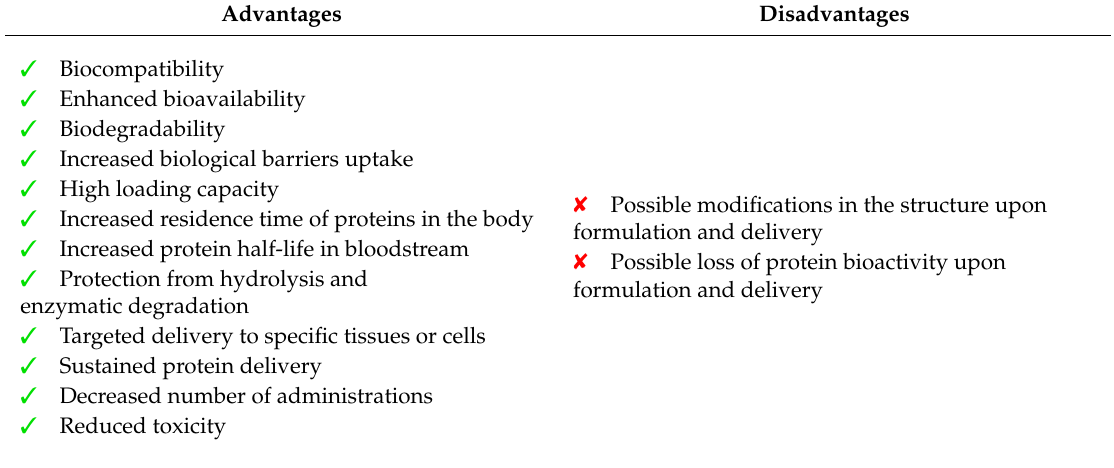
Table 1. Advantages and disadvantages of protein loading into